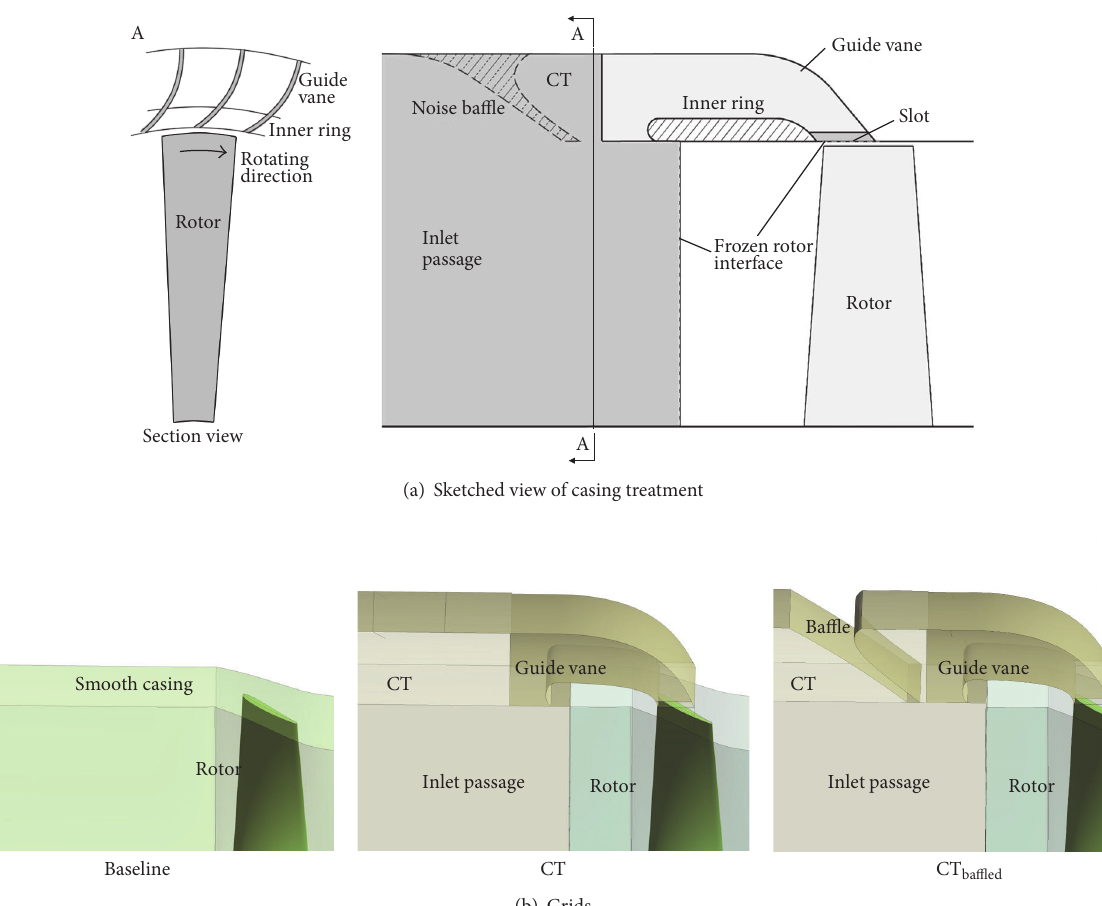
Figure 3: Geometry and grids of the counter-swirl self-recirculation casing